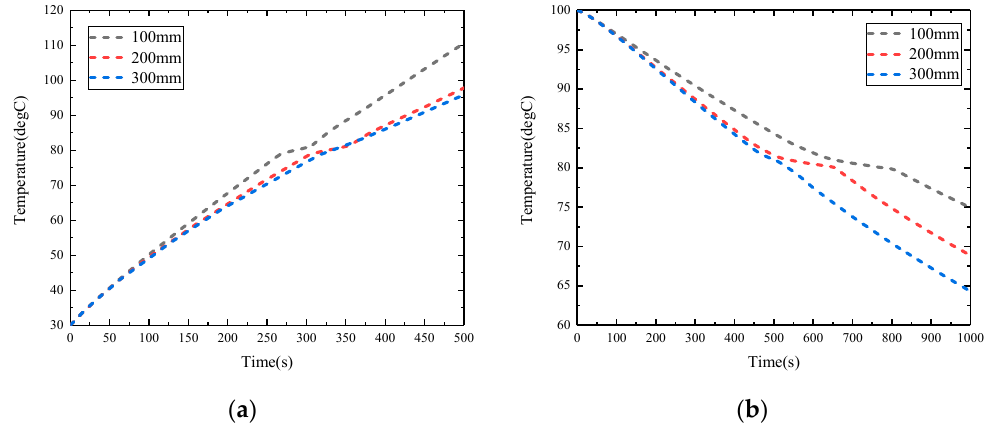
Figure 7. The time-temperature curves for three different fins. ( a ) The time-temperature curves under full load conditions; ( b ) The time-temperature curves under no-load conditions.